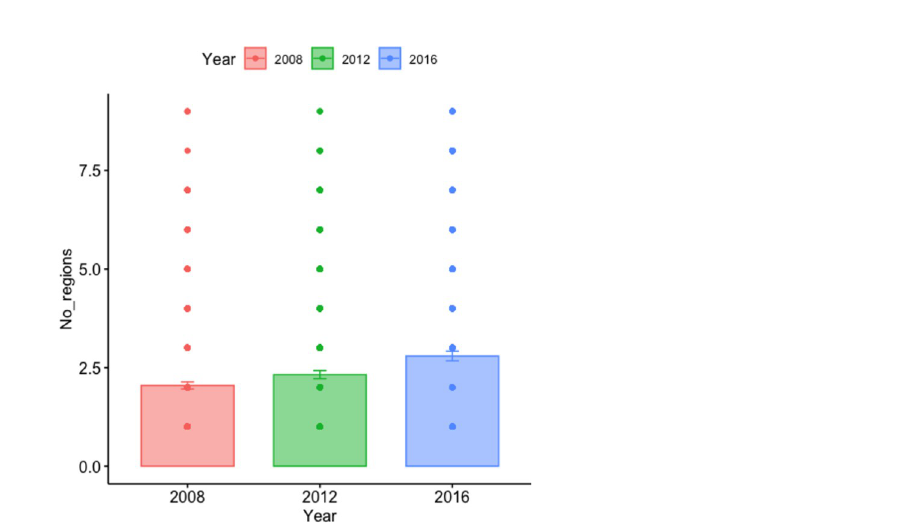
Fig 5. Development of the number of regions registered per clinical trial over time from 2008–2019.